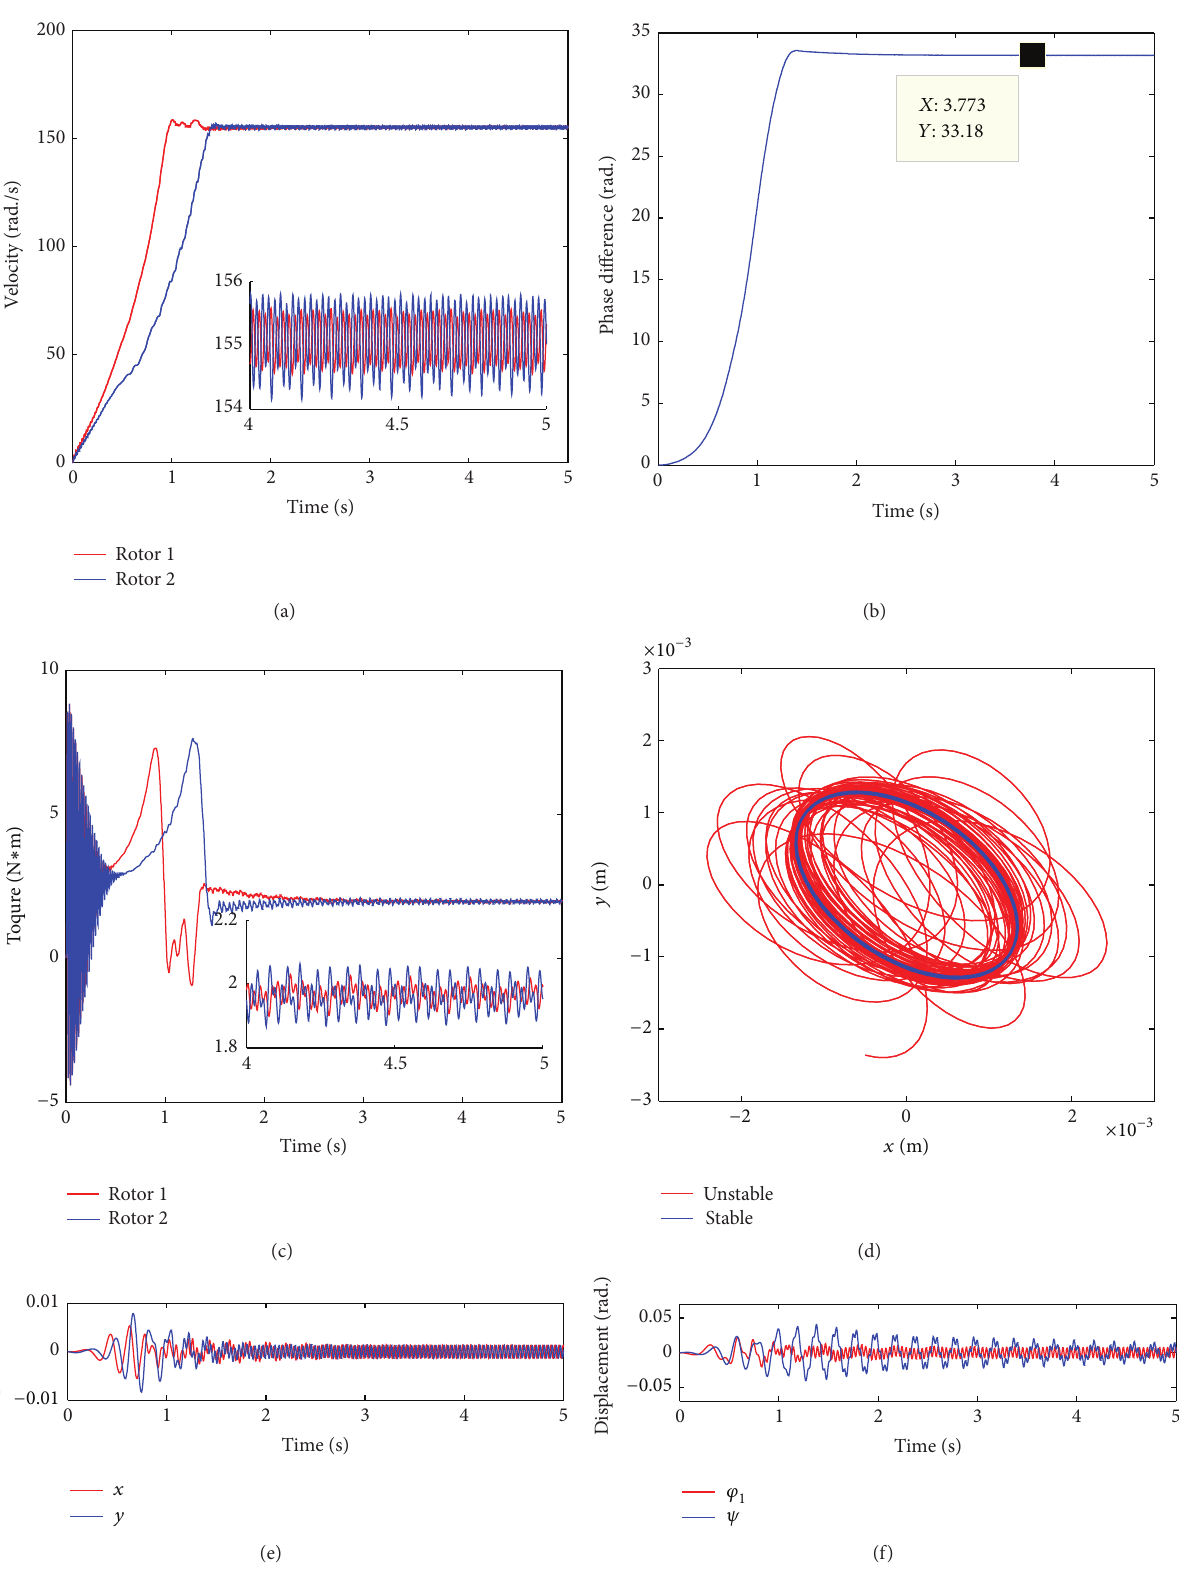
Figure 10: Simulation results for SACWA: (a) rotational velocity, (b) phase difference of the two rotors, (c) torques of the two rotors, (d) trajectory of mass center of the vibrobody, (e) displacement responses of the vibrobody in 𝑥 - and 𝑦 -directions, and (f) displacement responses of the vibrobody in 𝜑 1 - and 𝜓